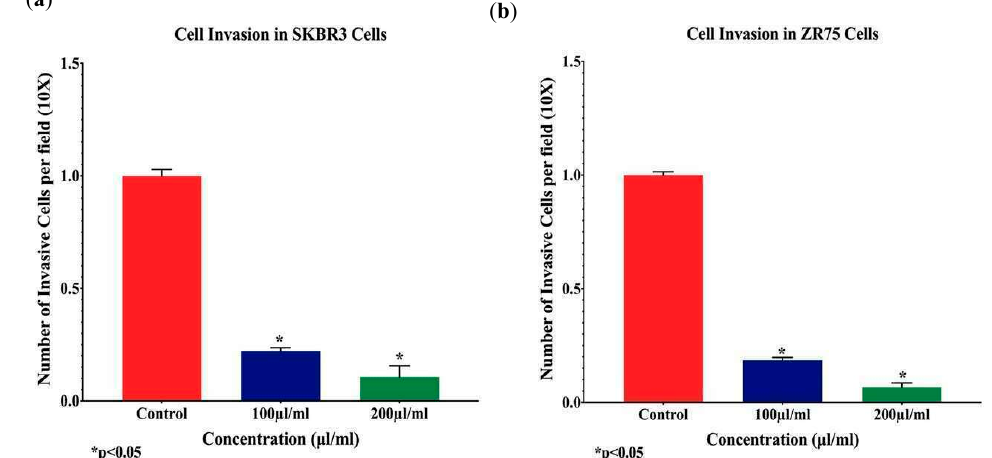
Figure 5. ( a , b ): The effects of EA flower extract on cell invasion of human HER2-positive breast cancer cells. EA extract inhibits cell invasion ability of SKBR3 ( a ) and ZR75-1 ( b ) cell lines by approximately 70% in comparison with their matched control cells (unexposed) ( p < 0.05). Boyden chambers were used to assess cell-invasion ability of SKBR3 and ZR75-1 cell lines. Cancer cells treated for 24 h with 100 and 200 µL/mL EA plant extract showed a significant inhibition of cell invasion in both cell lines, when compared with their matched control ( p < 0.05). Data are quantified by normalizing the number of invasive cells by their total number.